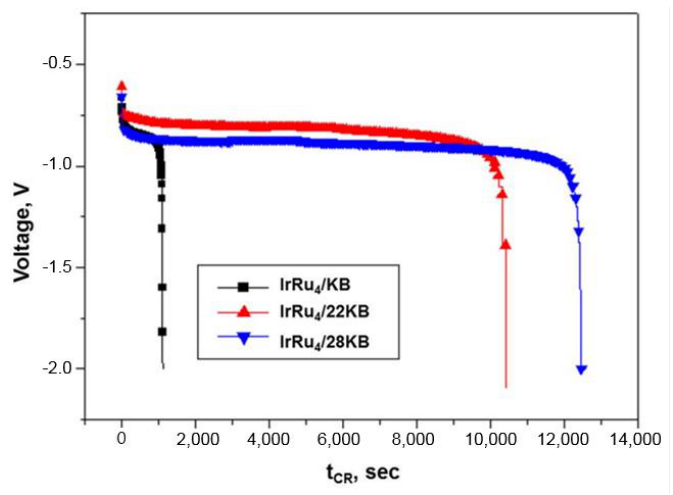
Figure 4. Voltage–time (V–t) plot of IrRu 4 /KB, IrRu 4 /22 KB and IrRu 4 /28 KB anode MEAs during the cell reversal test.